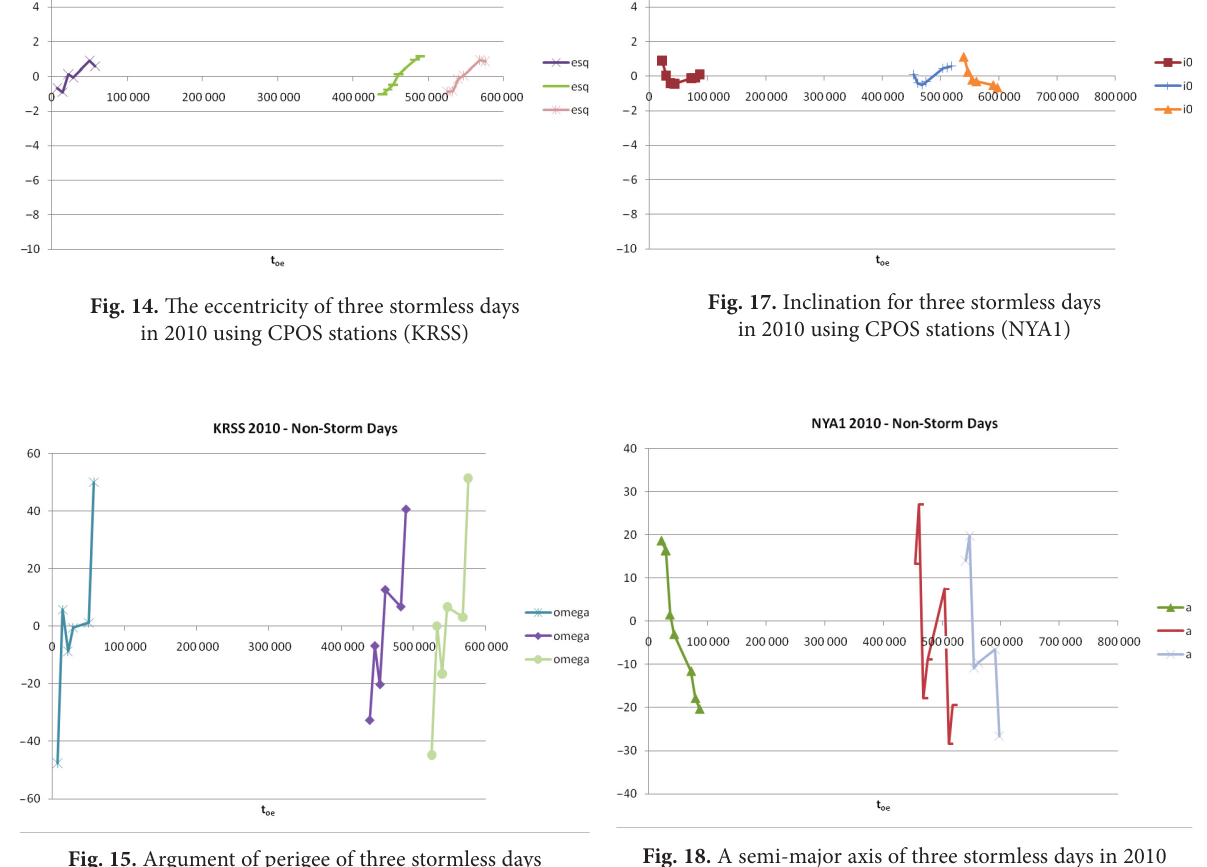
Fig. 15. argument of perigee of three stormless days in 2010 using cPOS stations (KRSS)